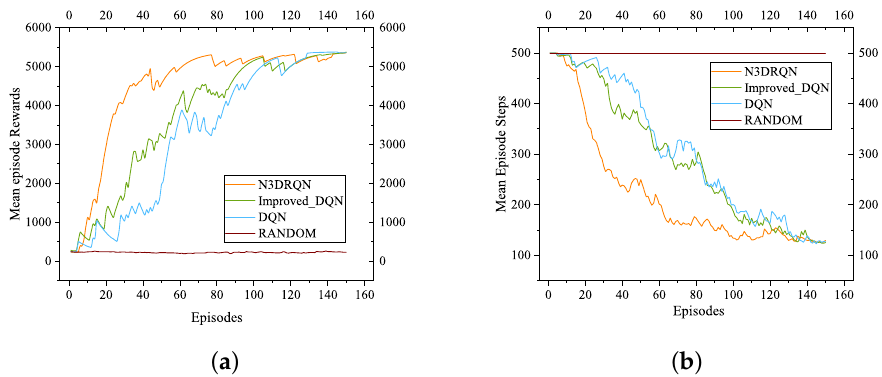
Figure 5. Mean rewards versus training episodes in the Toyctf environment. ( a ) Mean episode rewards in the Toyctf environment. The horizontal axis represents the cumulative number of episodes used by the agent to execute the action. The vertical axis represents the cumulative rewards as the agent interacting with the environment. ( b ) Mean episode steps in the Toyctf environment. The horizontal axis represents the cumulative number of episodes used by the agent to execute the action. The vertical axis represents the number of steps decided by the agent per episode.